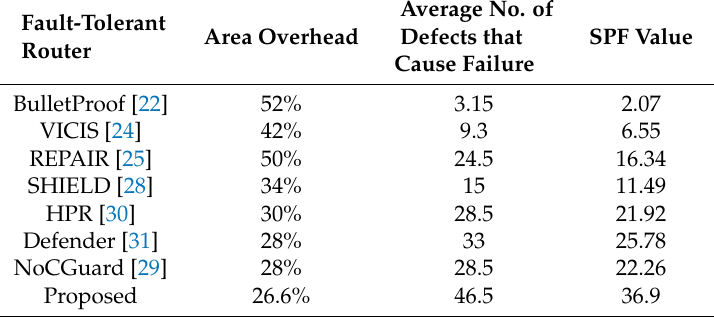
Silicon protection factor (SPF) comparison with state-of-the-art fault-tolerant router